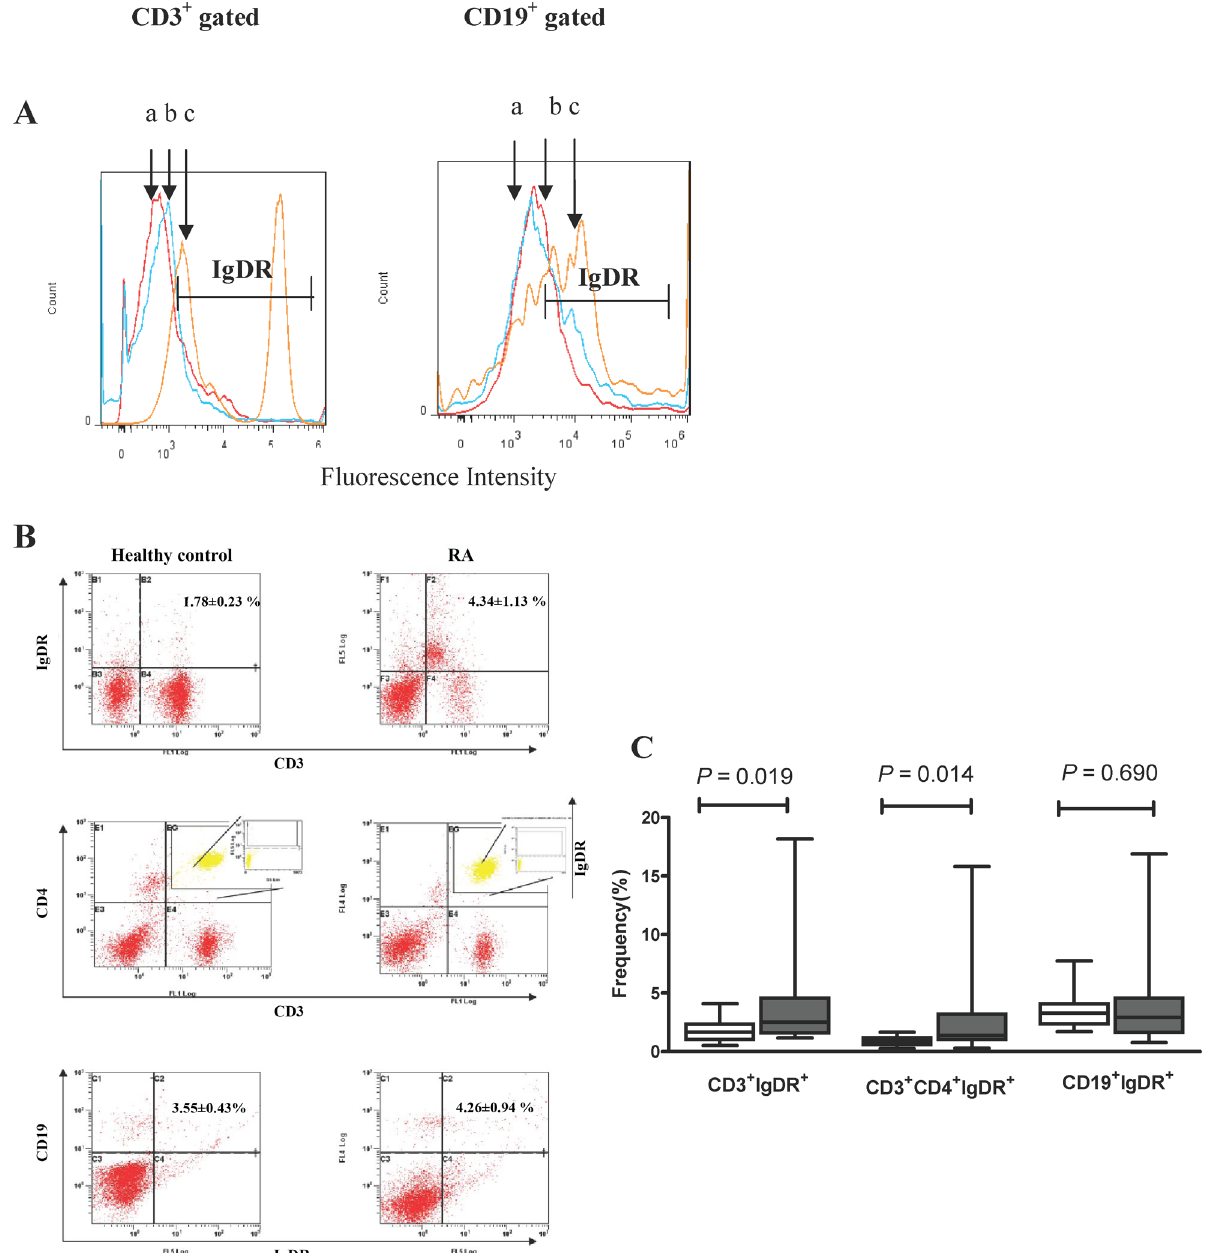
Fig 3. Expression of IgDR on T cells and B cells in RA patients and healthy controls. (A): A histogram showing the expression of IgDR on CD3 + T cells and CD19 + gated B cells. The fluorescence profile of the stained cells was analyzed by flow cytometry. Red curve (a): isotype; blue curve (b): healthy control; orange curve (c): RA patient. (B): A dot plot showing the expression of IgDR on T cells and B cells. (C): Box-plots representing the 10th, 25th, 50th (median), 75th and 90th percentiles of the frequencies of the CD3 + IgDR + , CD3 + CD4 + IgDR + and CD19 + IgDR + (each as a percentage of lymphocytes) in the peripheral blood of healthy controls (n = 15, white bars) and RA patients (n = 19, grey bars). P < 0.05 was considered statistically significant. doi:10.1371/journal.pone.0147788.g003 of activated B cells (CD19 + CD23 + , CD19 + CD21 + ), mature B cells (CD19 + IgD + ), and plasma cells (CD19 - CD138 + ; P < 0.05) were increased and the percentage of immature B cells (CD19 + IgM + IgD - ) was slightly decreased (though not significantly) when co-cultured with IgD (10 μ g/ml) or PHA (4 μ g/ml) in RA patients. IgD had no significant effect on total B cells